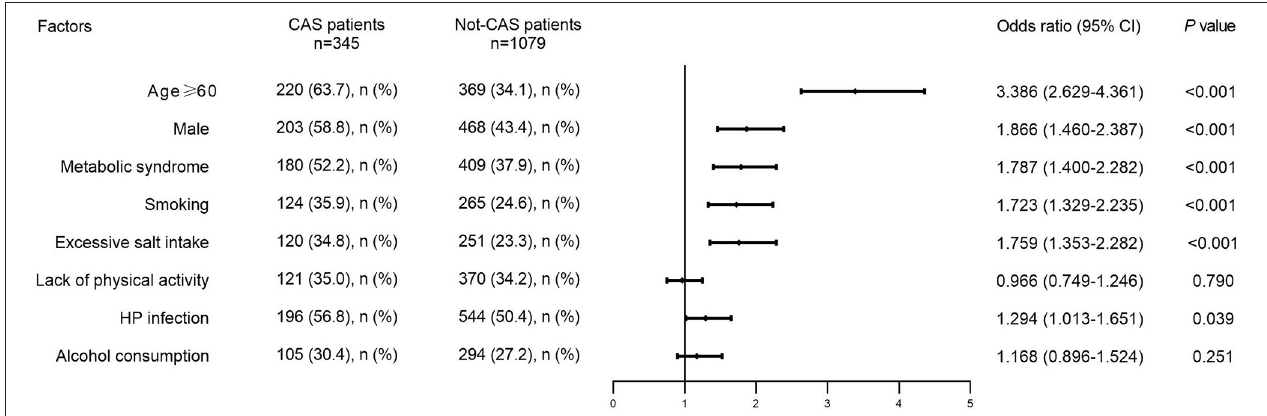
FIGURE 2 | Distribution of potential risk factors in CAS patients and not-CAS patients. CAS, carotid atherosclerosis; HP, Helicobacter pylori .